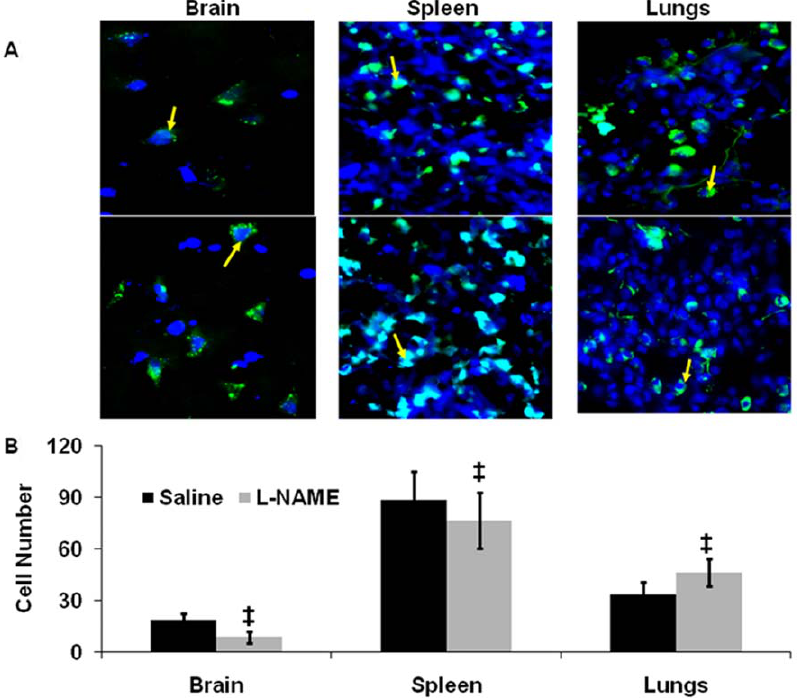
Figure 4. Biodistribution of MNC in brain, spleen and lungs after IV administration of MNCs(10 million) at 24 hrs after stroke. MNCs were labeled with Q-tracker(green). These animals had undergone stroke, 24 hrs later were injected with MNCs IV and then sacrificed 1 hr afterwards. Sections were prepared at 1 hr after injection and counterstained with DAPI (blue). L-NAME was injected via IP 1 hr prior to MNC administration. N=3 per group. (A): Representative microscopic pictures illustrating MNCs (green + blue) in animals pre-treated with L-NAME (top row) or saline (bottom row). Magnification: 400 6 . (B): A histogram illustrating the mean number of labeled MNCs per high power field in the brain, spleen, and lungs. Animals were pre-treated with L-NAME before IV injection of MNCs or animals were pre-treated with saline followed by IV injection of MNCs ( { p , 0.05).